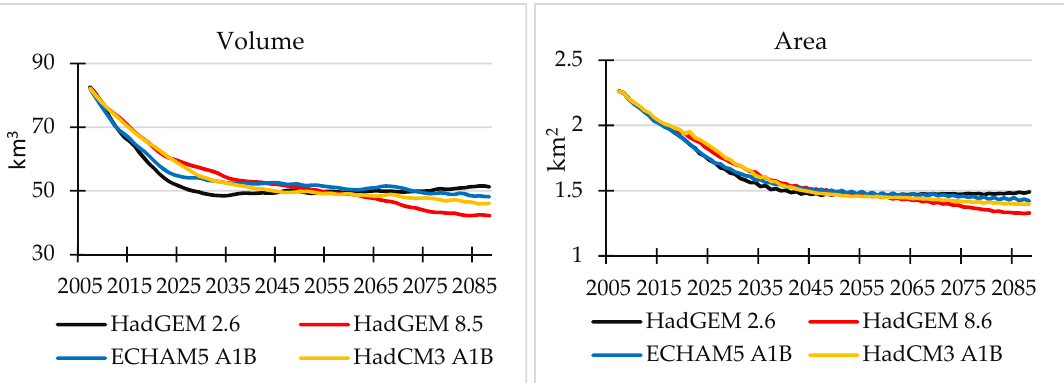
Figure 8. Projected changes in volume and area of Tuyuksu glacier. Glacier stabilization is projected at the middle of the century. Under the most aggressive HadGEM 8.5 scenario glacier wastage continues until the end of the century.